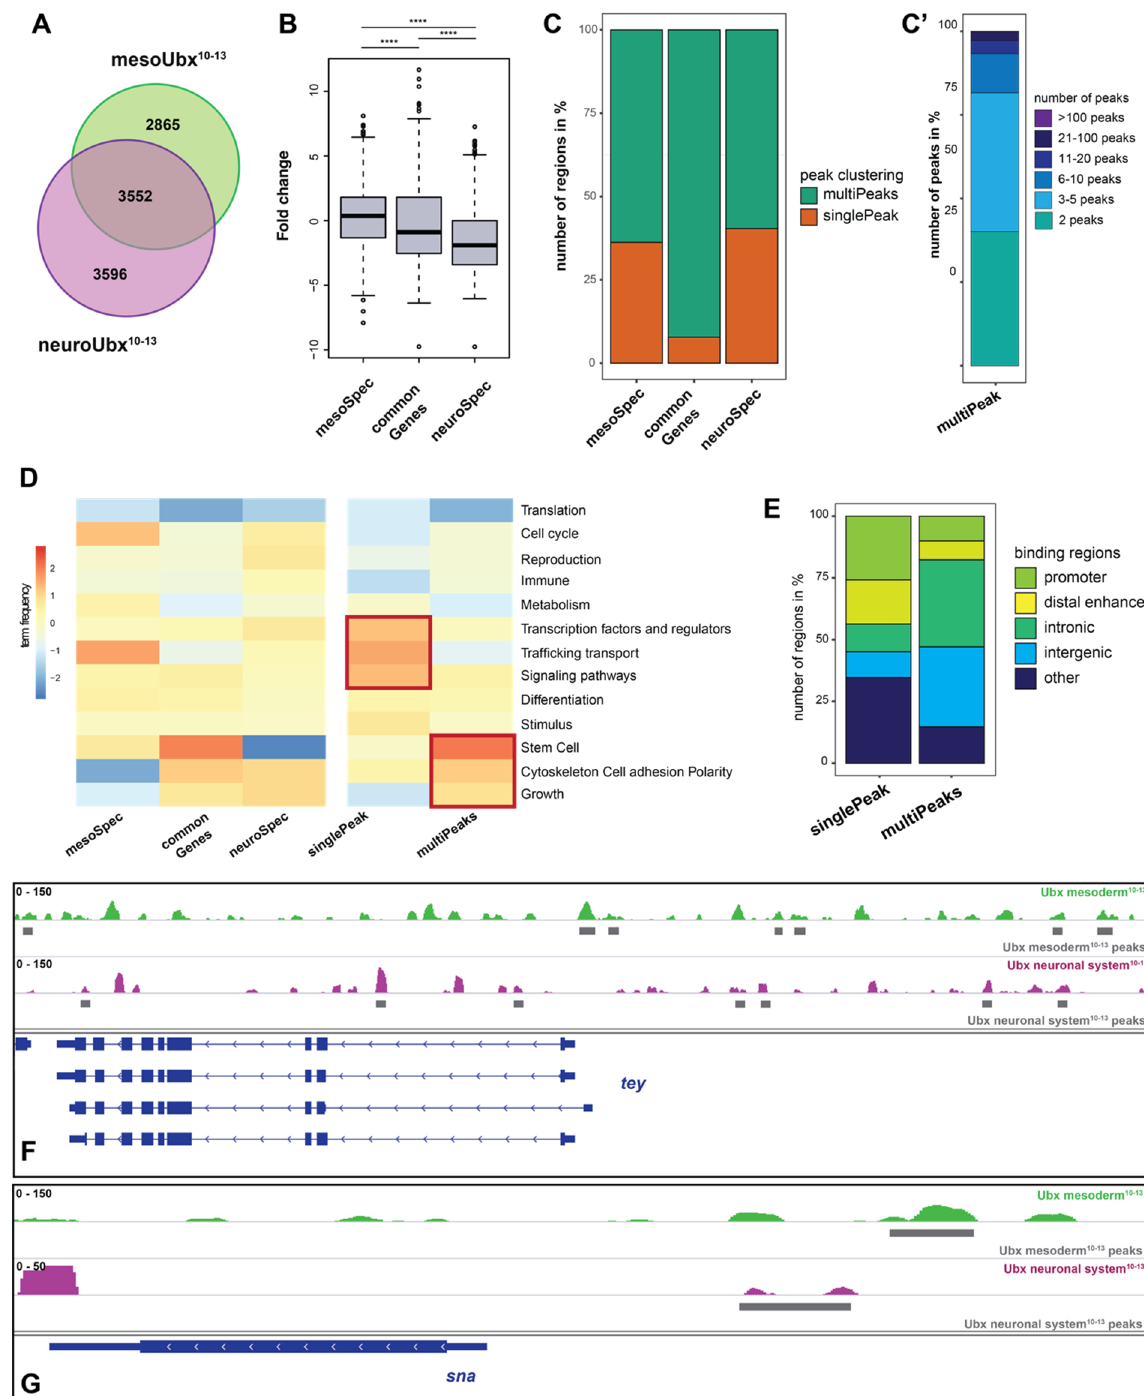
Figure 2. Ubx interacts with multiple chromatin sites in the vicinity of genes. ( A ) Venn diagram of Ubx peaks associated genes in the mesodermal and neuronal tissue, showing a substantial overlap of co-bound and potentially co-regulated genes (common genes). ( B ) Box plot of the DiffBind analysis highlighting the significant difference between tissue specific Ubx peaks and the co-bound genes (common genes). p -value **** is < 2.2 × 10 − 16 according to the Wilcox rank test. ( C ) Bar diagram of the peak clustering, indicating that the majority of the common genes contain multiple Ubx peaks (multiPeaks) as compared to the tissue specific peaks, 30–40% single bound genes (singlePeak). ( C’ ) Detailed analysis of the common mutiPeaks, showing the frequency of peaks appearing at a single gene ( D ) Heat map of higher order GO-term clustering among the mesoSpec, common and neuroSpec genes. This analysis shows that single peaks are mostly found at genes functionally related to transcription factors, trafficking transport, and signaling pathways, while multiple peaks are found at genes involved in stem cell functions, cytoskeleton cell adhesion polarity and growth. ( E ) Bar diagram of the Ubx peak localization with respect to the gene body. Classified as promoters ( − 1000 to +10 bp from transcription start site (TSS), 5 ′